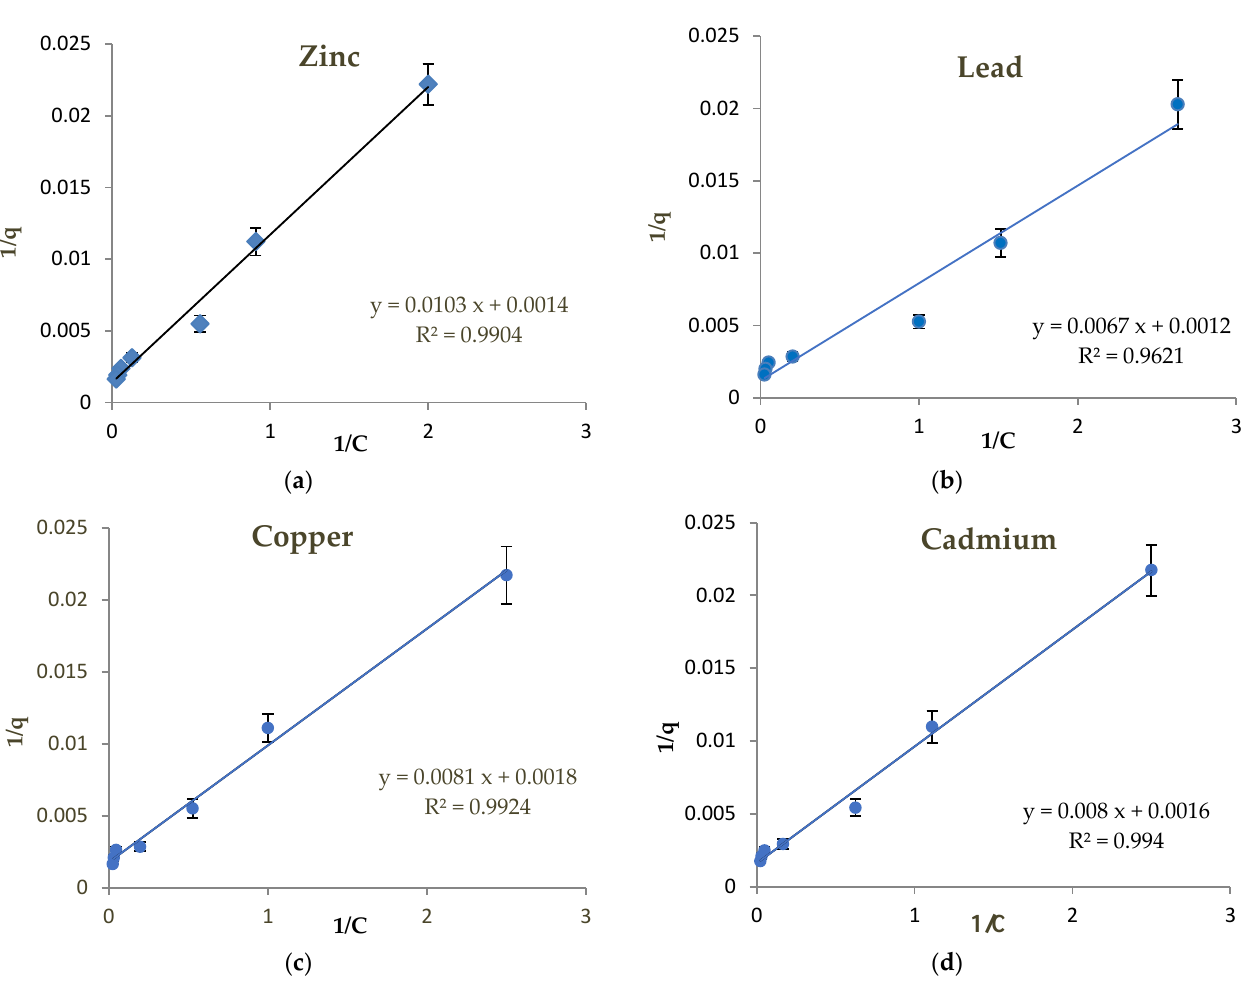
8 of 15 Table 2. Freundlich and Langmuir isotherm parameters for Zn, Pb, Cu, and Cd in both studied soils. Freundlich Parameters